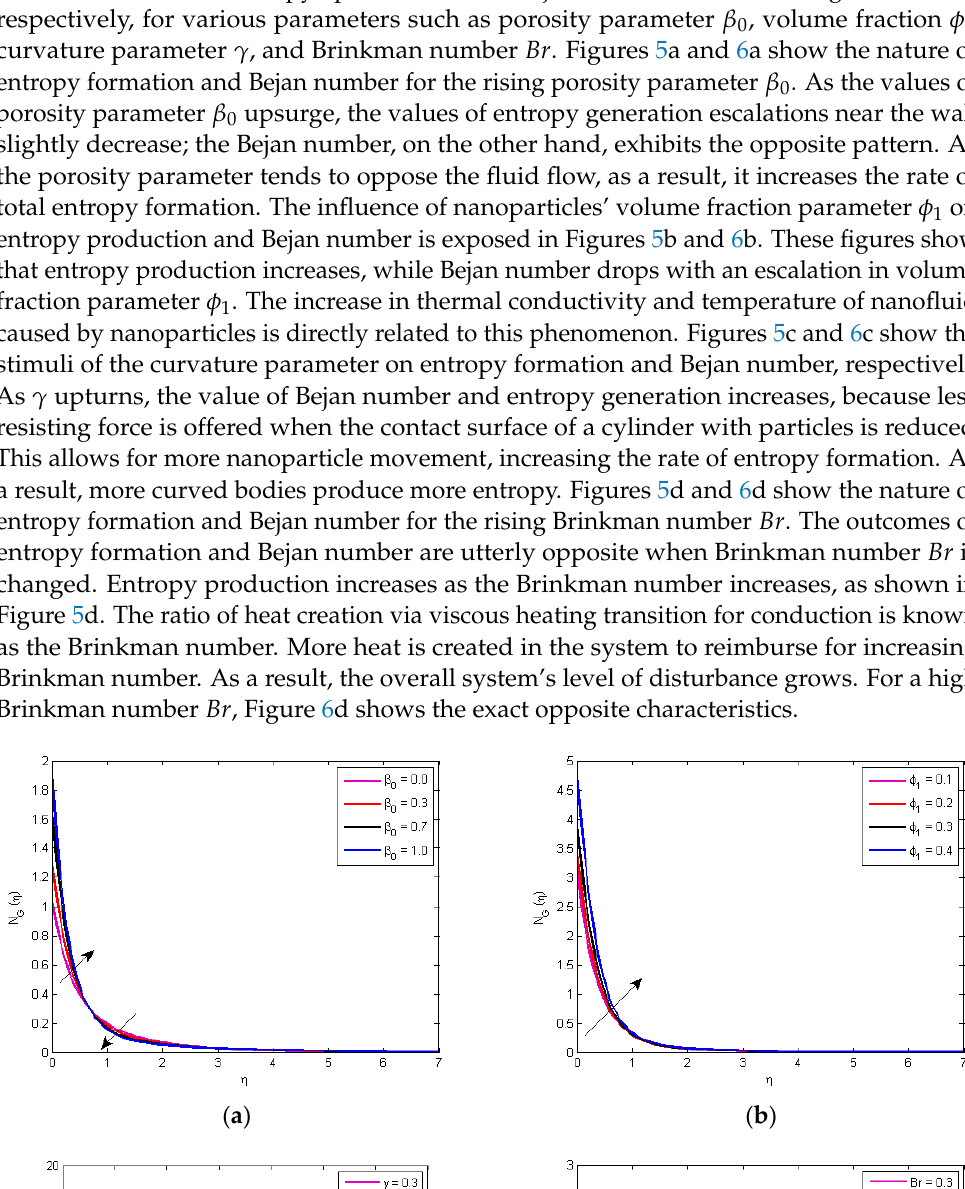
Figure 5. Entropy optimization variation for distinct values of ( a ) is β 0 , ( b ) is φ 1 , ( c ) is γ , ( d ) is Br .